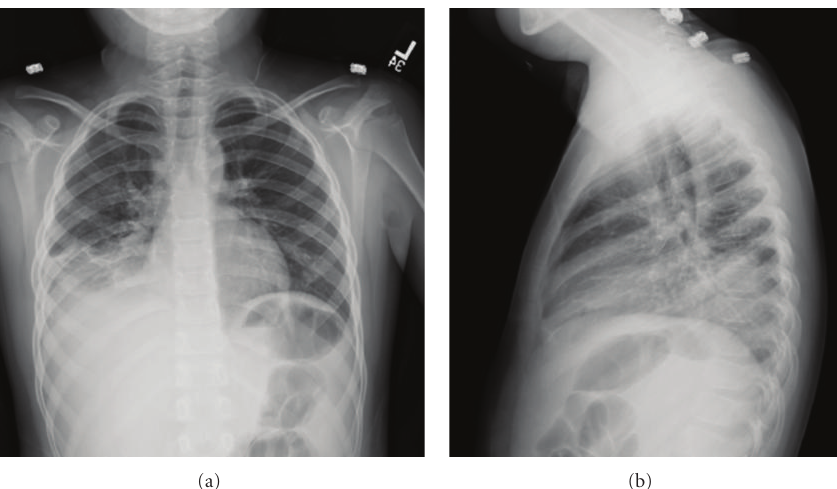
Figure 1: Chest radiographs during admission. Images demonstrating right lower lobe infiltrates. These films were taken at 9 years of age.